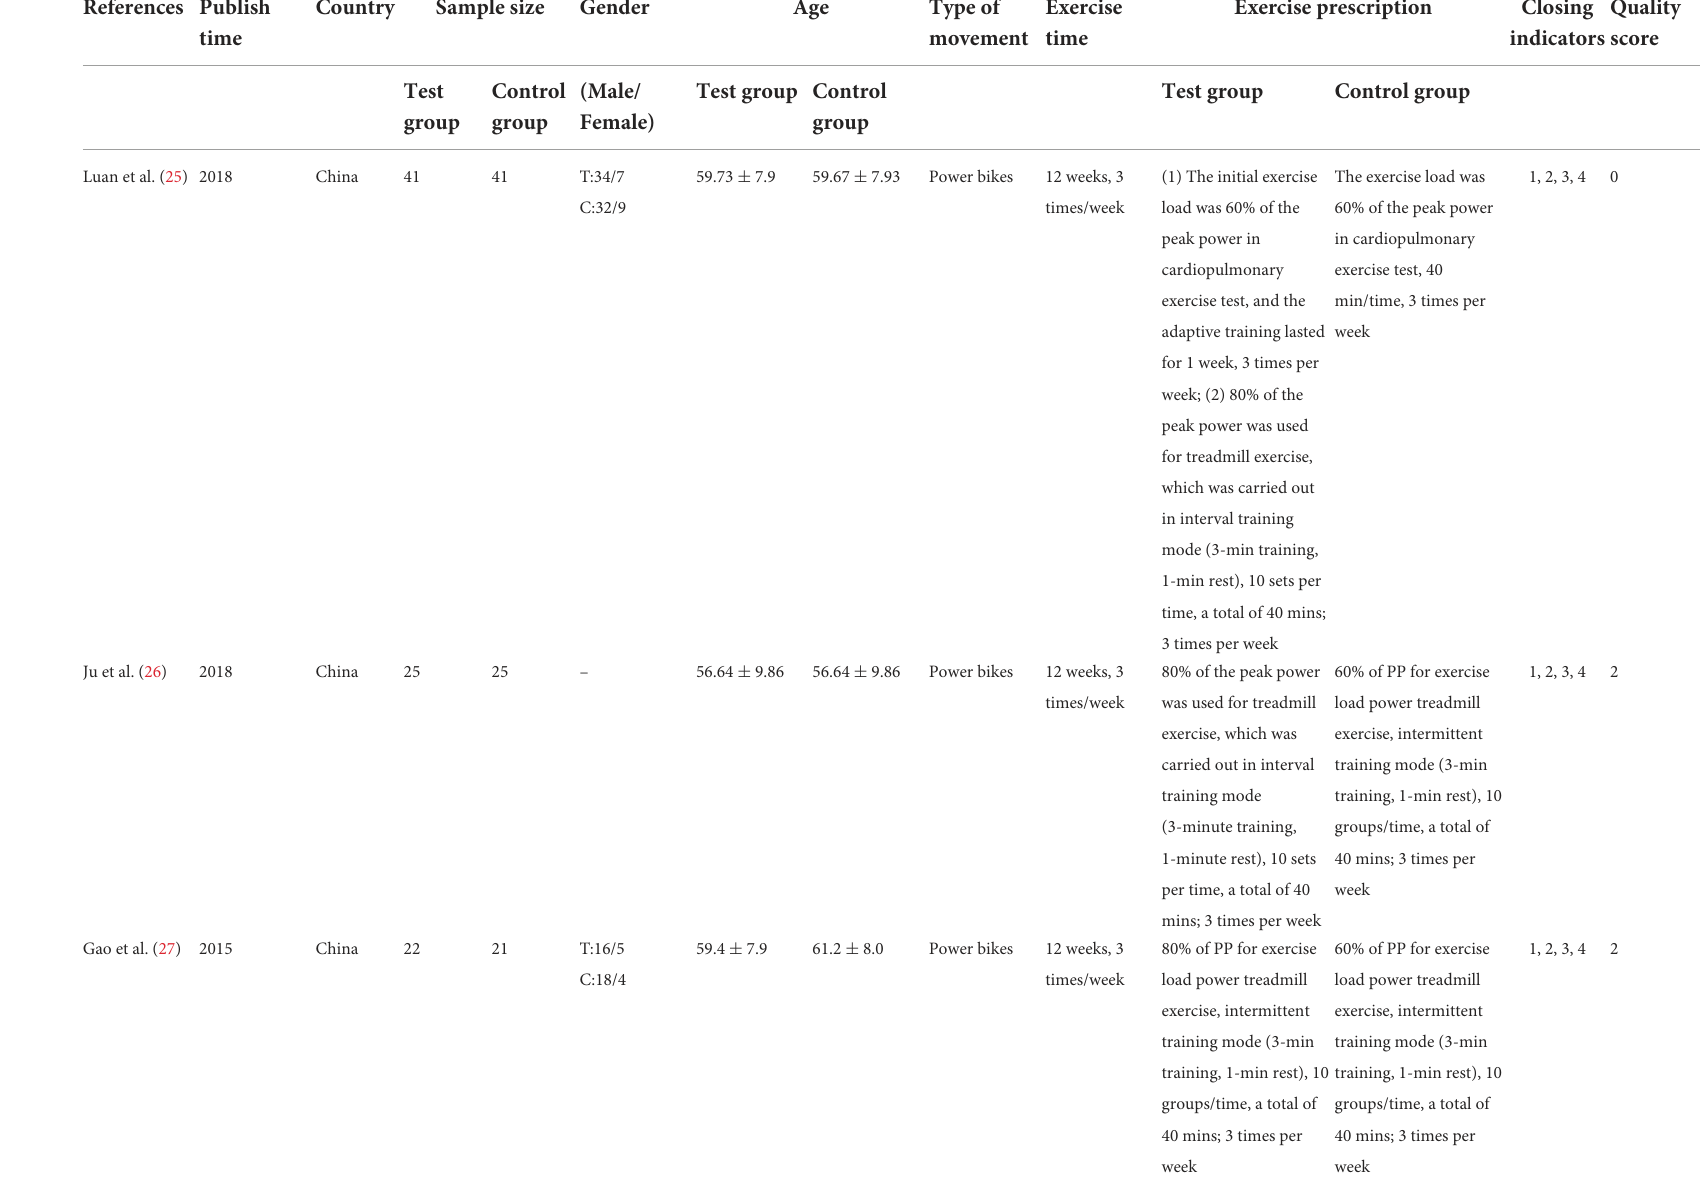
TABLE 2 Characteristics of included